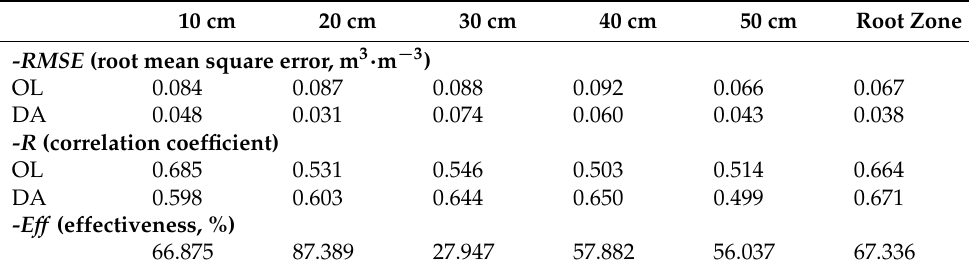
Table 2. Statistics of open-loop (OL) and assimilated (DA) soil moisture at the HBBZ site. 10